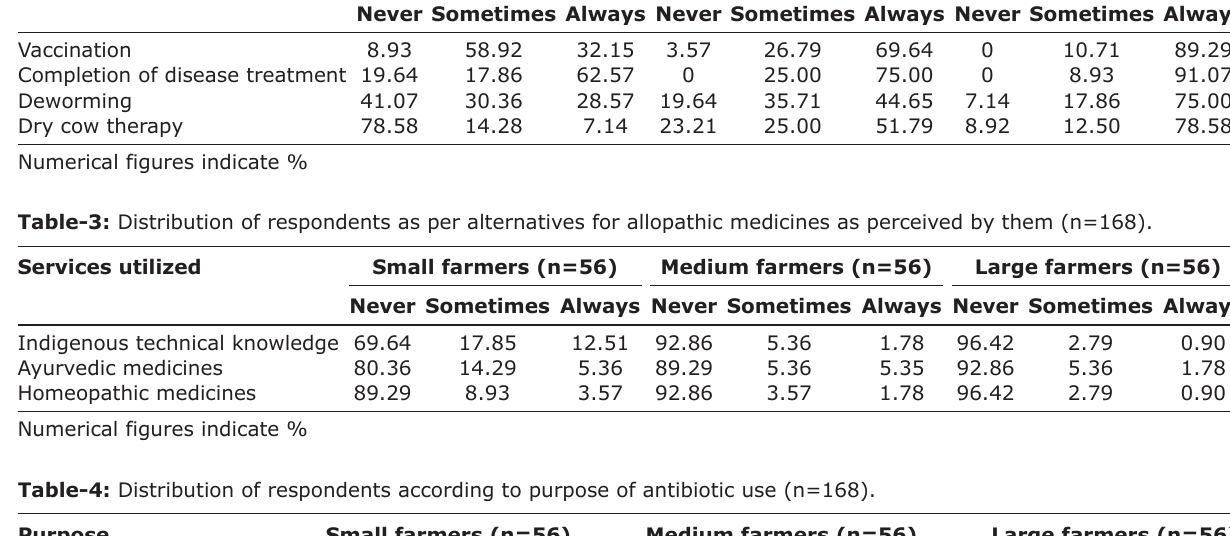
Table-2: Distribution of farmers as per veterinary consultancy services utilized by them (n=168). Services utilized